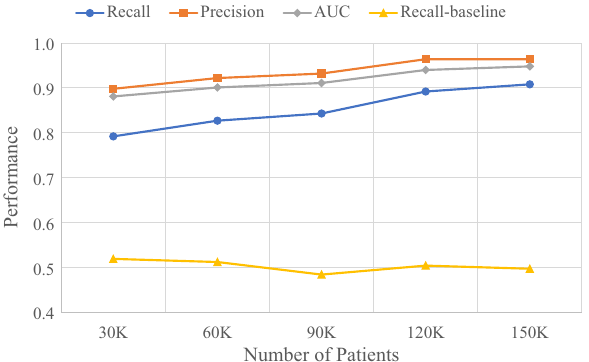
Figure 6. Continuous improvement of XGBoost base models for stroke risk prediction with dataset size increase over time. Model performance was measured by recall, precision and AUC. The recall of the baseline model with 10 variables is shown as